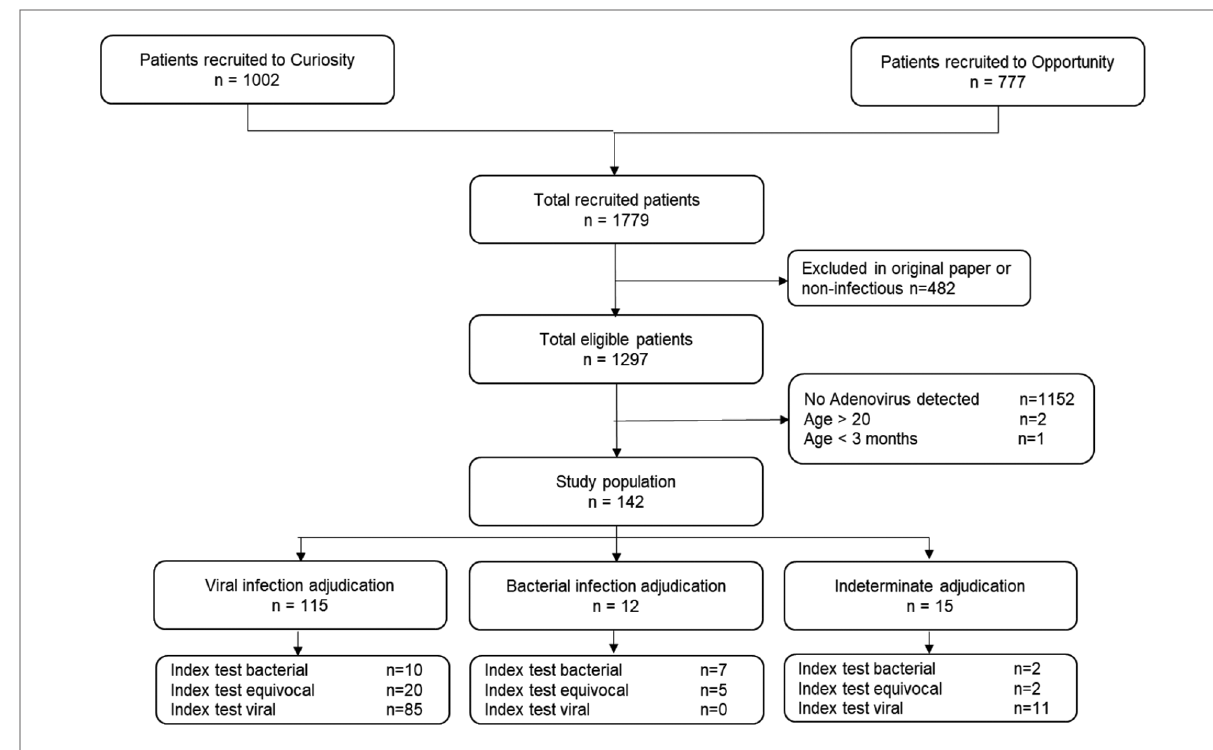
FIGURE 1 Patient enrollment fl